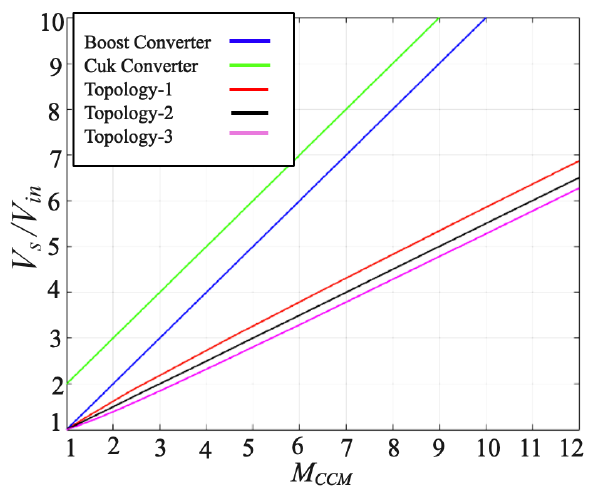
Figure 14. Comparison of converters in terms of normalized switch voltage